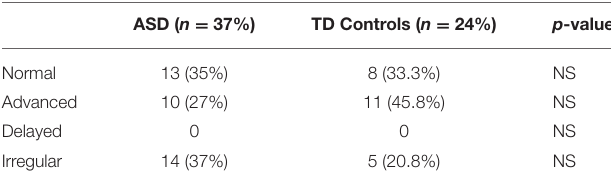
within Tanner stage II (ASD 19.26 ± 9.30, TD controls 53.35 ± 56.75, p = 0.19). BMI was not associated with peak melatonin level, peak time, or DLMO time in either groups.